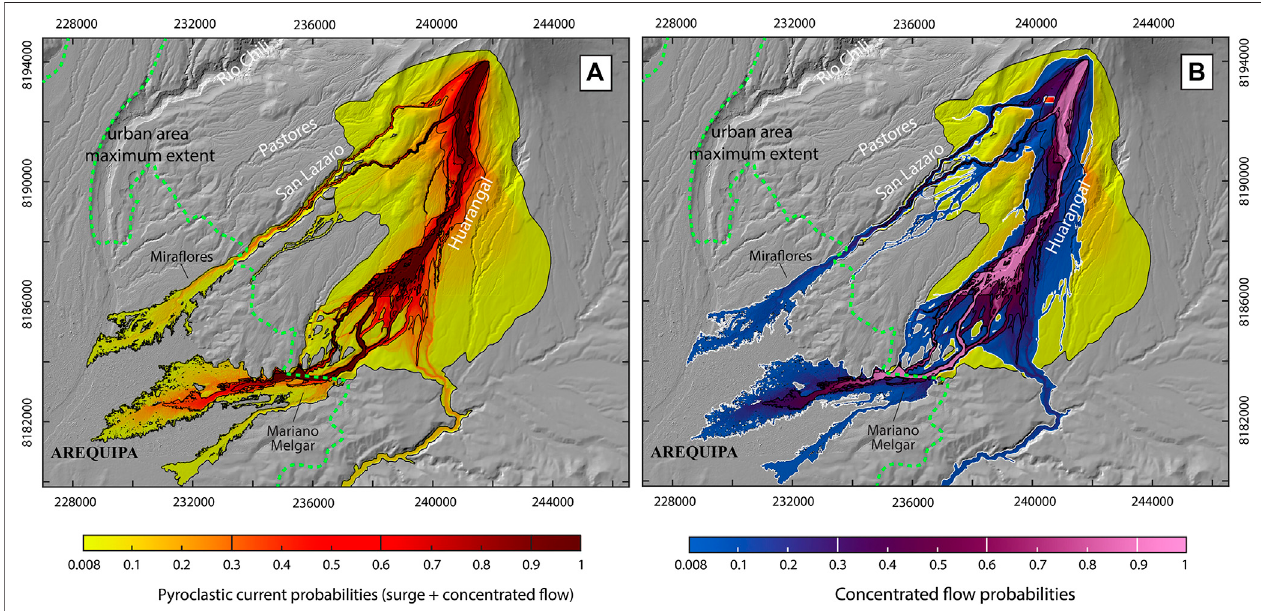
FIGURE9| VolcFlowprobabilisticmapforapyroclastic currentintheHuarangal-MarianoMelgarcatchment,madebycalculatingthenumberofhitsateachdigital surfacemodelcellfor123numericalsimulations.Map (A) showstheprobabilitiesfortheentirepyroclasticcurrent(i.e.,dilute+concentratedparts).Map (B) distinguishes the probabilities of a concentrated pyroclastic current with a blue to pink color scale, from the dilute pyroclastic current with a yellow to red color scale. Iso-probability contour lines at every 0.3 probability intervals are also included. The green dashed line corresponds to the maximum extent of the Arequipa urban area.